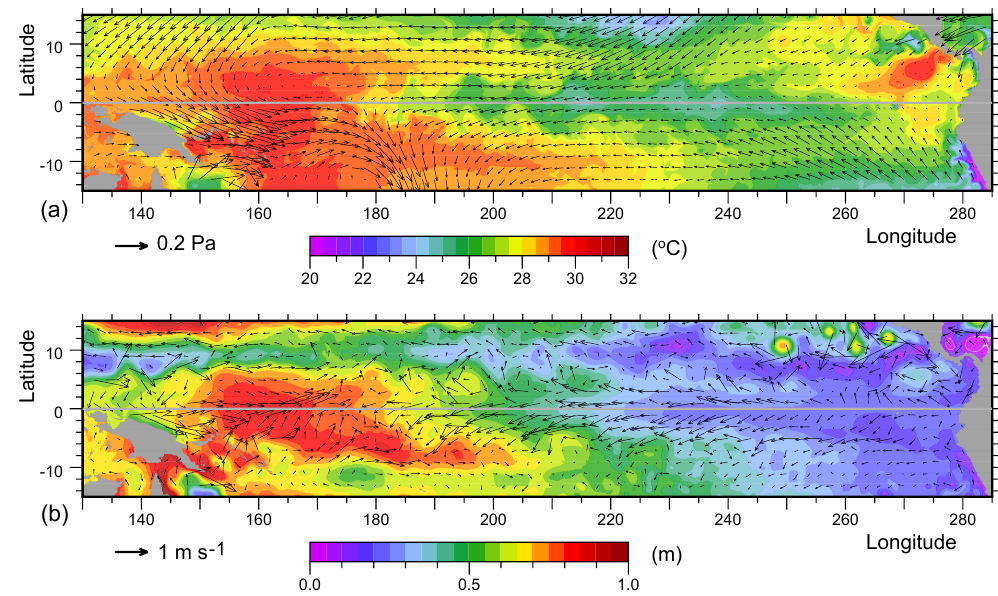
Figure 33. (a) Surface temperature and wind stress vectors. (b) Sea level (SSH) and velocity vectors are from the 16 March 1997 archive dataset. Each archive dataset contains averages over the previous 5 days of the model run.